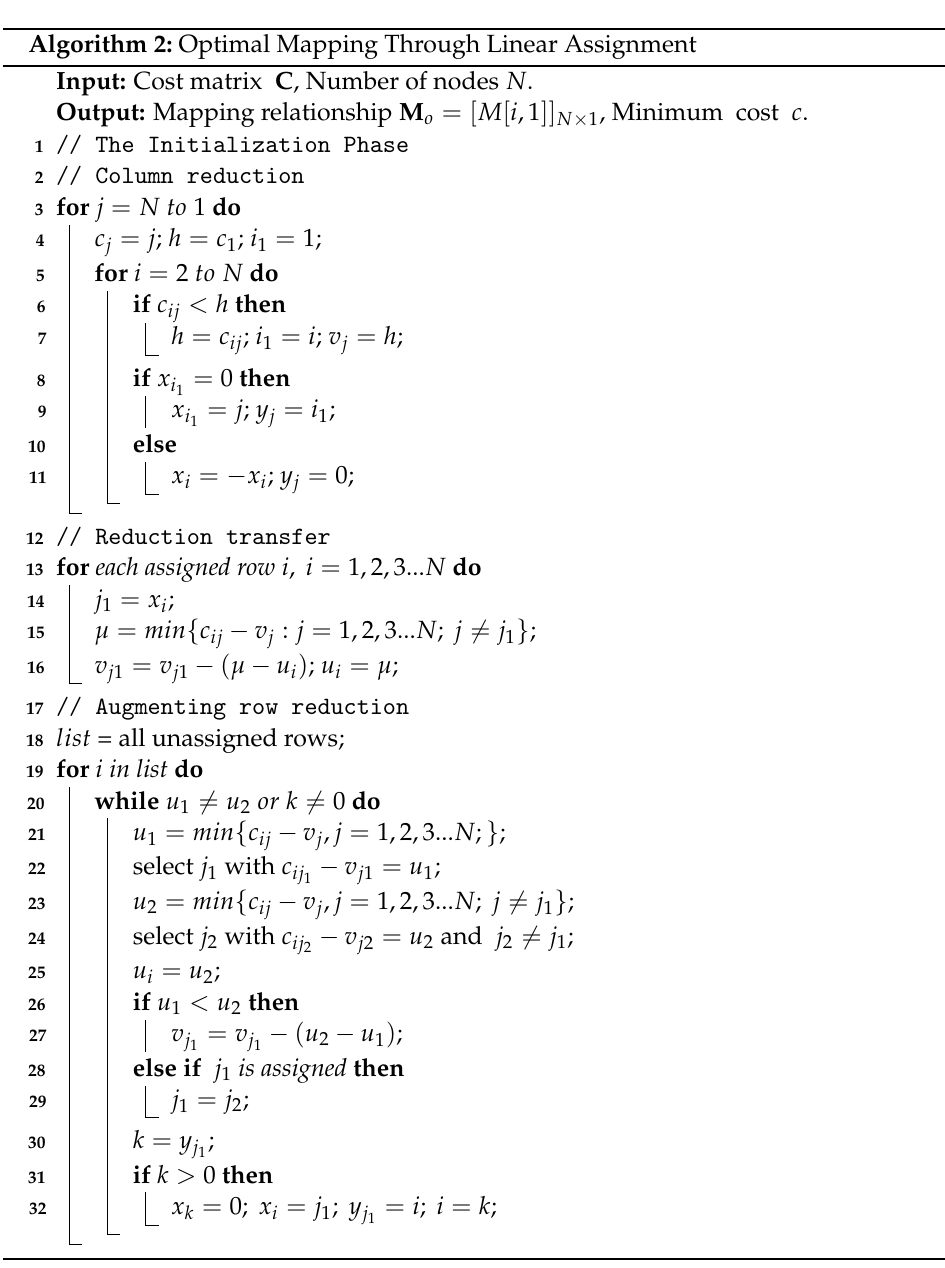
Algorithm 2: Optimal Mapping Through Linear